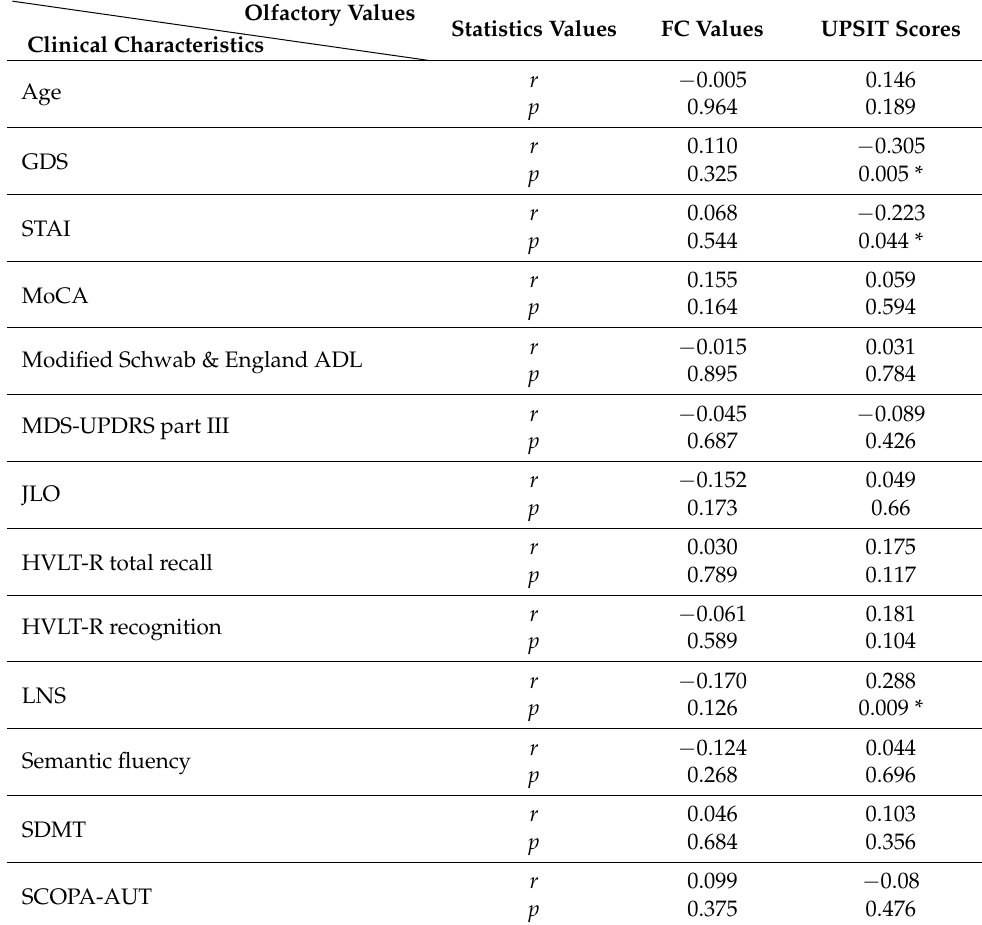
Table 2. Correlations between clinical characteristics and dCC functional connectivity between the left EC and the right dCC in patients with PD.